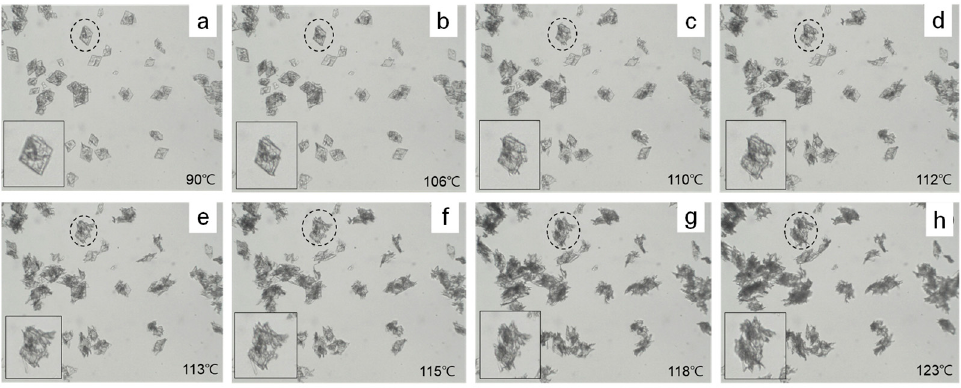
Figure 8. Hot-stage microscopy (HSM) thermal scanning (heating rate 10 °C/min, temperature range: 30 °C–200 °C) of DBE monohydrate: ( a ) 90 °C, ( b ) 106 °C, ( c ) 110 °C, ( d ) 112 °C, ( e ) 113 °C, ( f ) 115 °C, ( g ) 118 °C, ( h ) 123 °C.